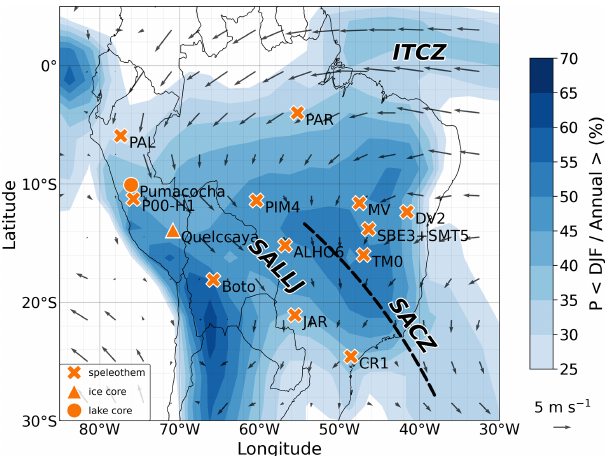
Figure 1. Oxygen isotope proxy network spanning the South Amer- ican Monsoon domain (details presented in Table 1). Color shading represents the percent of annual precipitation falling in December to February (DJF, austral summer) based on GPCP data (1979–2019). Vectors represent the low-level (850hPa) DJF wind field based on ERA5 data (1979–2019). Major dynamical features are